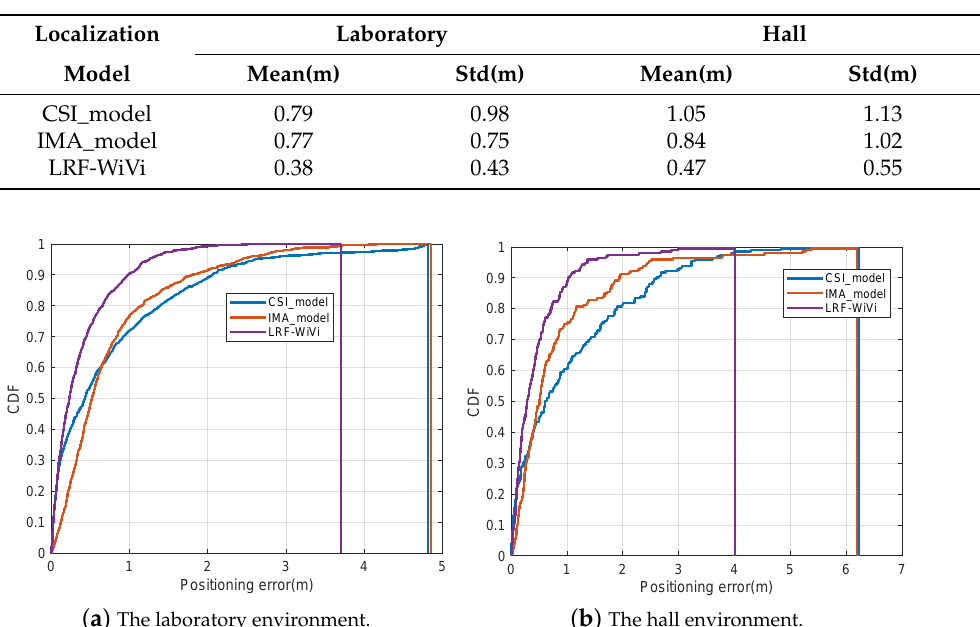
Table 2. Comparison of positioning mean error and standard deviation with single-source models.